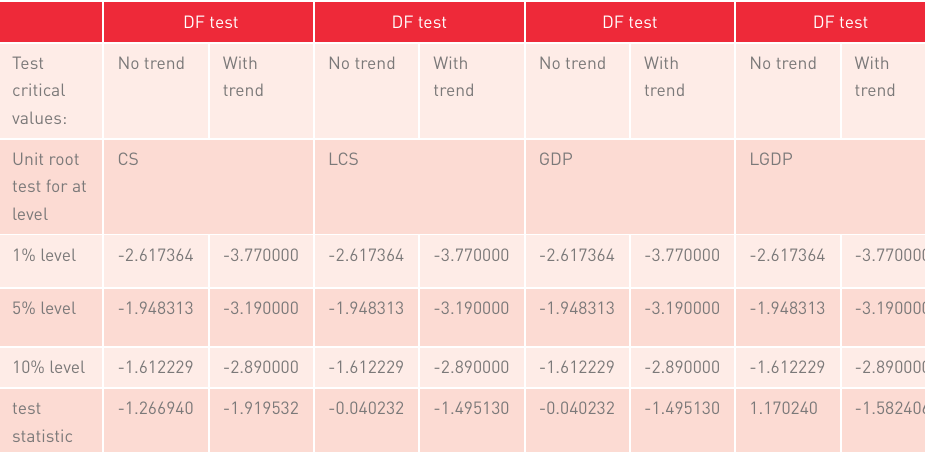
Unit root test for CS and GDP at level with